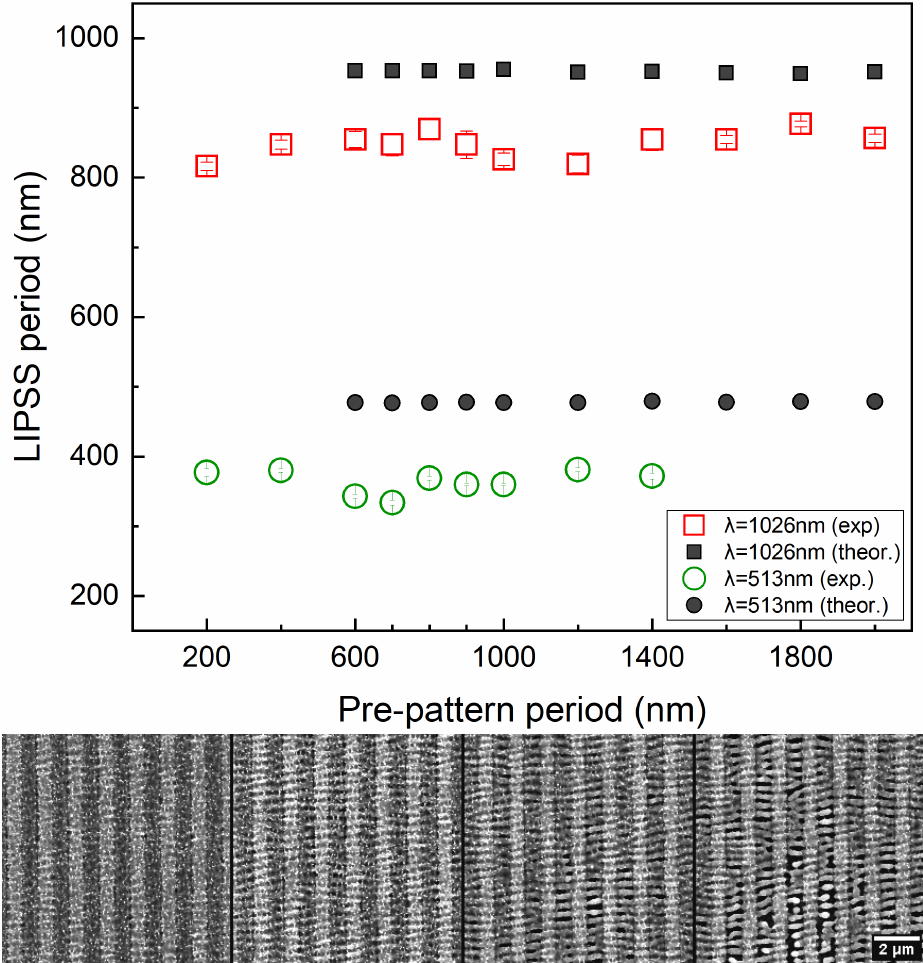
Figure 3. LIPSS spatial period as a function of pre-pattern periodicities. LIPSS on Nickel surfaces upon irradiation with 20 laser pulses (plot) with polarization parallel to the pre-pattern orientation. Experimental ( red empty squares) and theoretical ( black filled squares) values of the LIPSS periodicity upon irradiation with 1026nm laser pulses. The experimental ( green empty dots) and theoretical ( black filled dots) values of the LIPSS periodicity upon irradiation with 513nm laser pulses are also presented. The SEM micrographs below represent the evolution of LIPSS on pre-patterns with 1400nm period upon irradiation with 4, 10, 15 and 20 pulses (from left to right), following irradiation with pulses of wavelength λ = 513nm and peak fluence 0.12J/cm 2